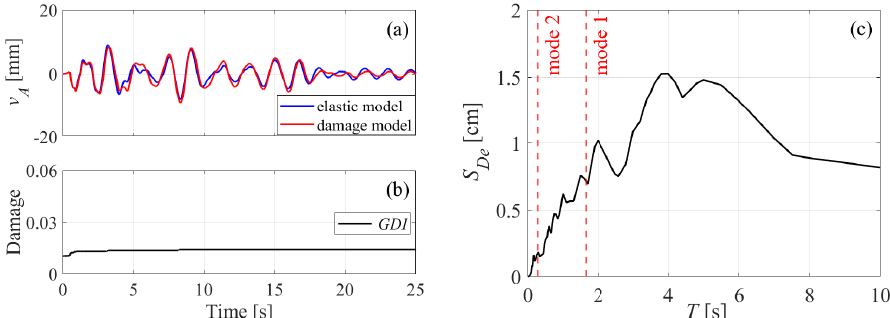
Figure 16. Earthquake FHC station: ( a ) elastic and damage responses of the equivalent pier, ( b ) evolution of the GDI , ( c ) elastic displacement spectrum.